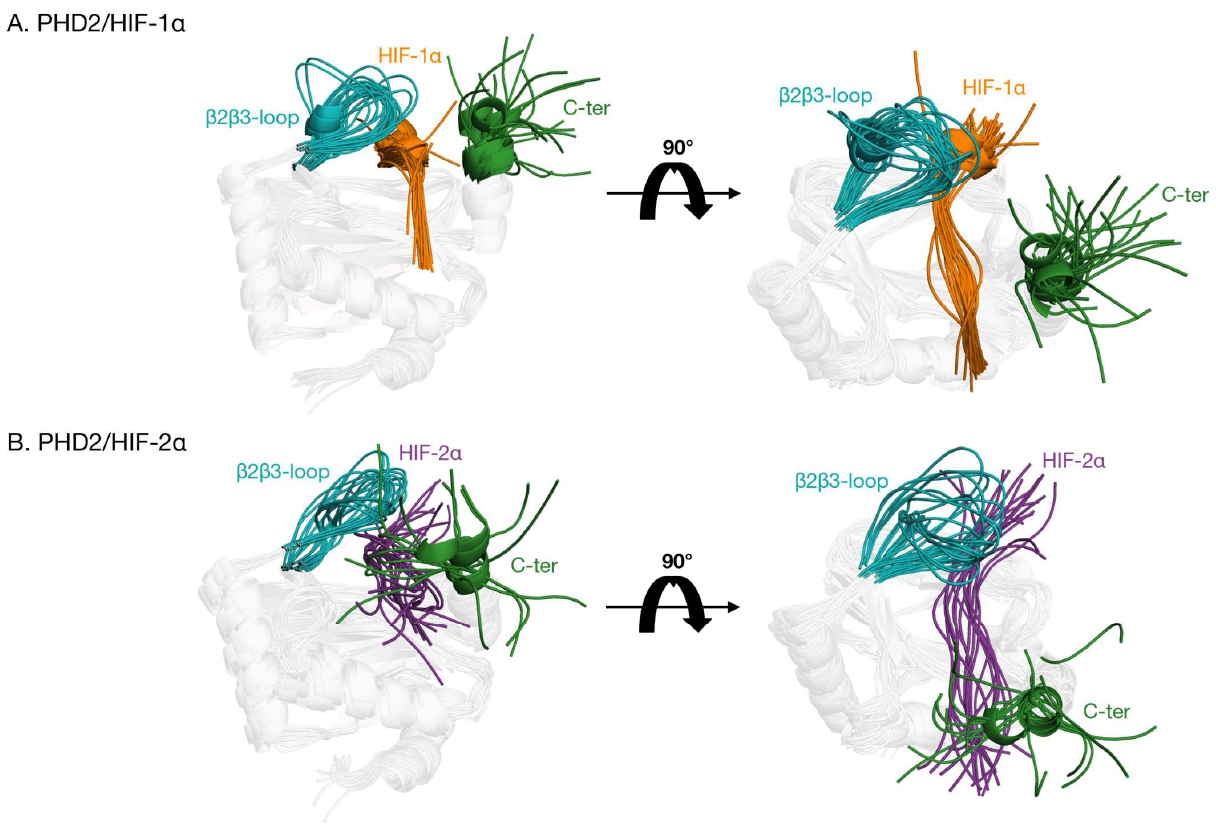
Figure 7. Superimpositions of the most representative PHD2/HIFs-α complexes conformations, with the β2β3-loop colored in teal, C-terminal in green, HIF-1α in orange, and HIF-2α in purple. On the left, a bird’s-eye view obtained with a 90° rotation of the complexes helps visualize the binding pocket. ( A ) PHD2/HIF-1α. ( B ) PHD2/HIF-2α.